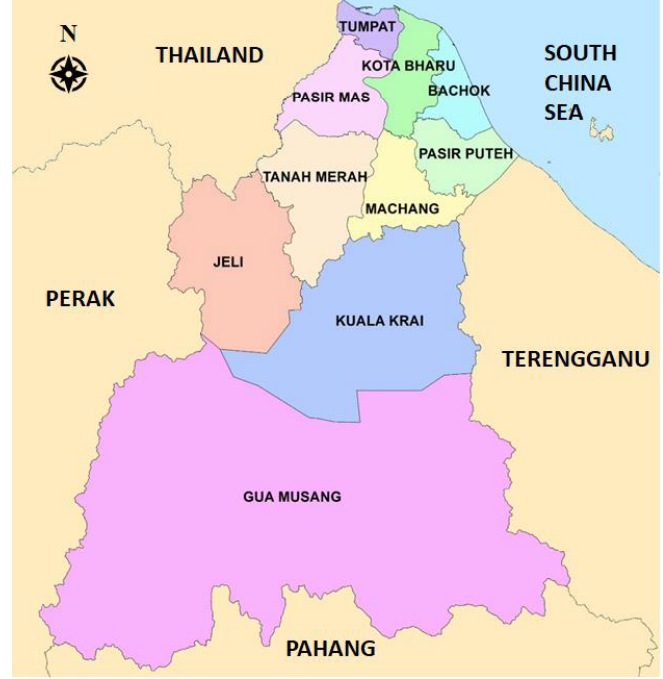
Figure 1. Map of